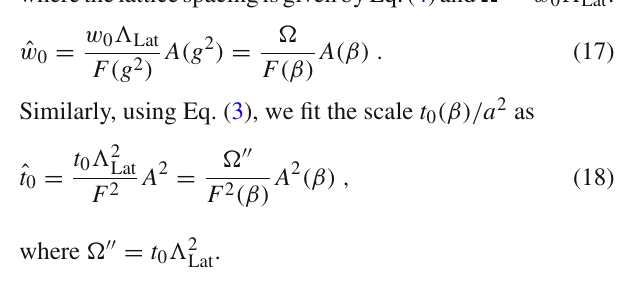
fits and the systematic error given by the difference between the two curves. The values presented in this plot are the ones used in the remain part of this work every time we need a correspondence between β and T / T c